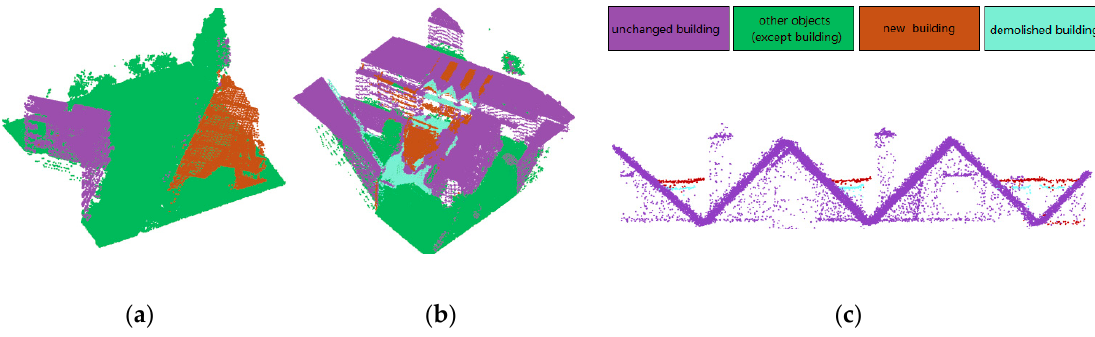
Figure 13. ( a , b ) Examples of large changes in buildings; ( c ) changes to dormer sizes in the merged data sets (removed dormers and extensions to dormers in height and length).